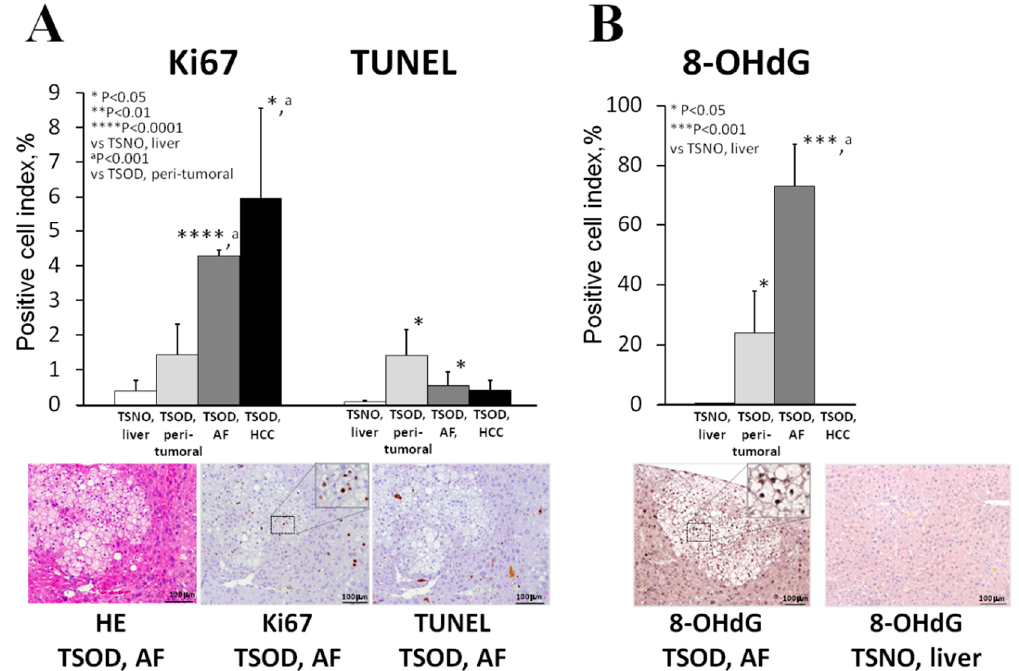
Figure 3. Alteration of cell proliferation (Ki67) and apoptosis (TUNEL) ( A ) and 8-hydroxydeoxyguanosine (8-OHdG) formation ( B ) in livers, altered foci (AF) and tumors of TSOD and TSNO mice. 2.7. Immunohistochemical Assessment of Urea Cycle Enzymes, Phosphokinases and β -catenin